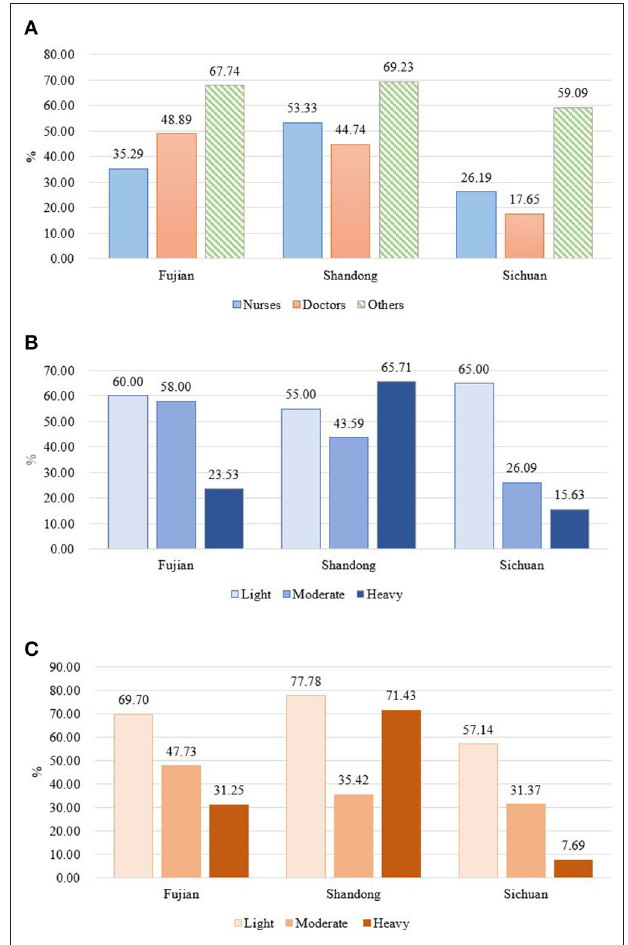
FIGURE 2 | The proportion of staff who would like their child to be a family doctor, stratified by study areas, self-report work pressure, and feeling of fatigue in different study areas. (A) Stratified by professional fields; (B) stratified by self-report work pressure; (C) stratified by self-report feeling of